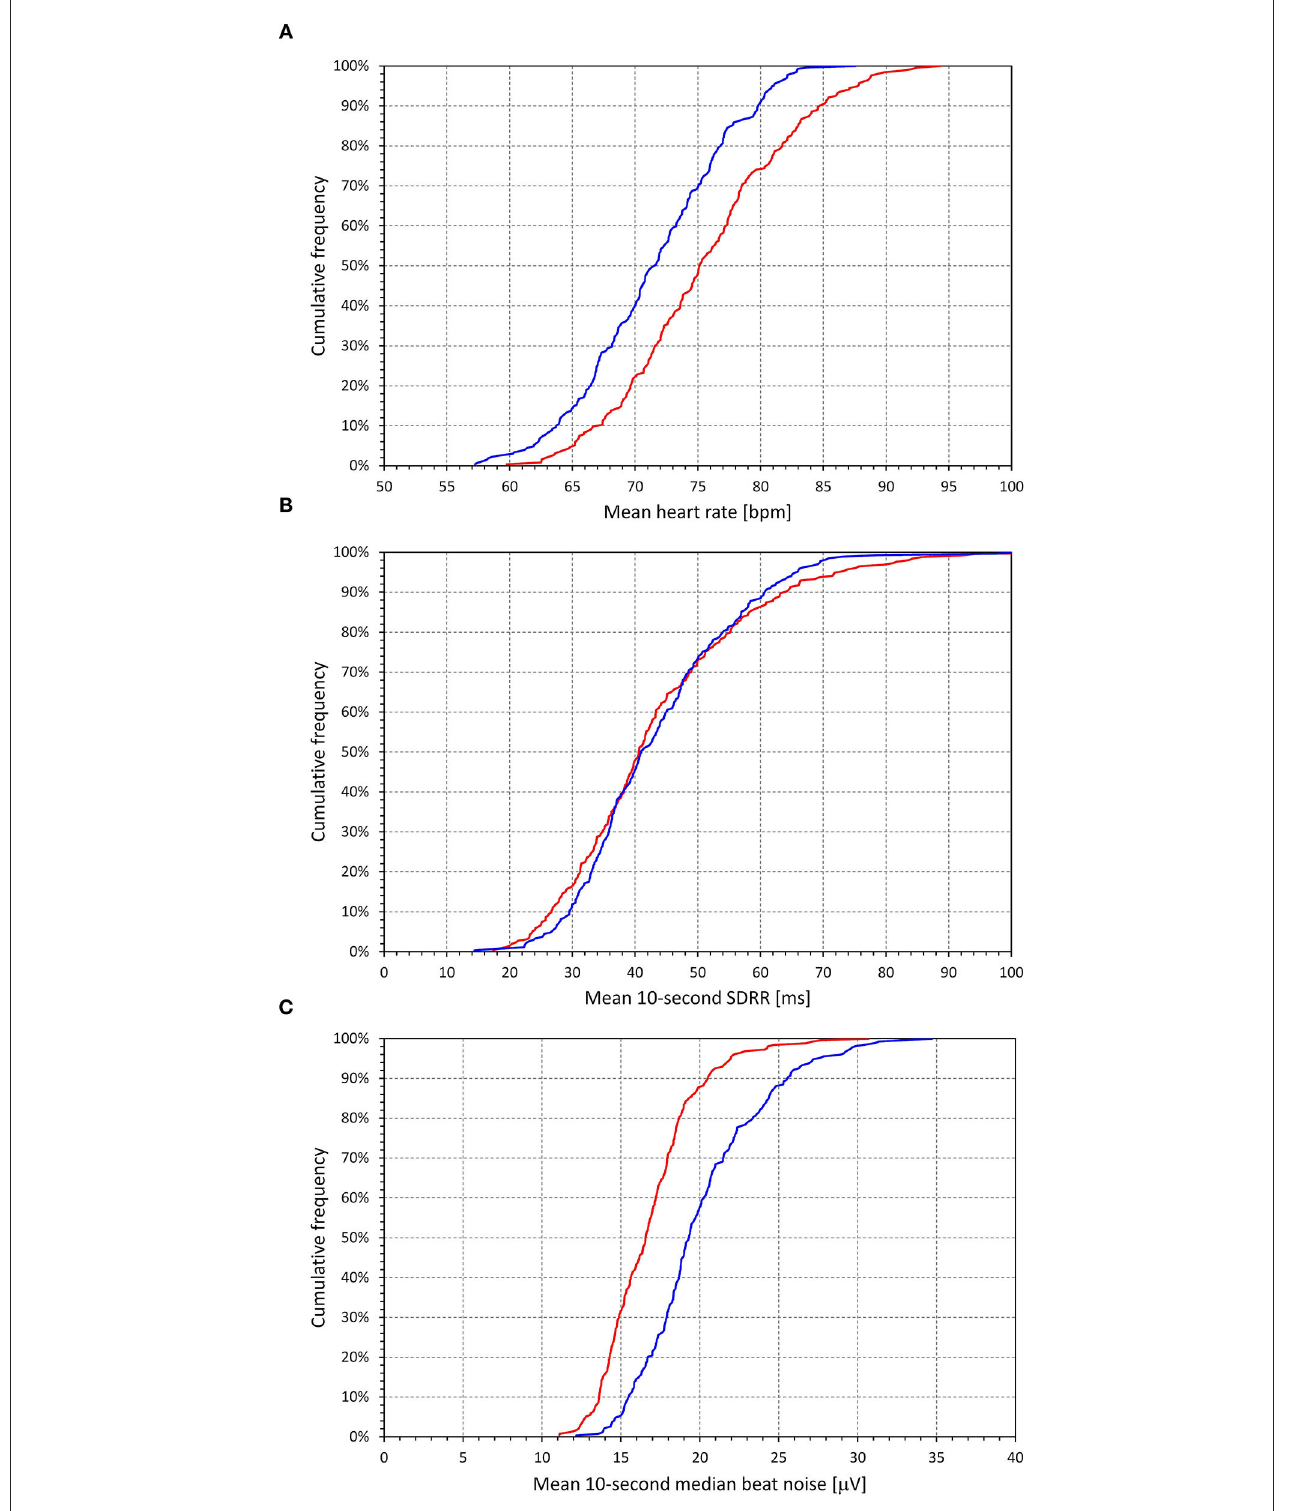
FIGURE 6 | Population distributions of principal ECG measurements (intra-subject means of measurements obtained in individual 10-s ECG segments accepted in the recordings of the given subject). The top (A) , middle (B) , and bottom (C) show the distributions of mean heart rates, mean values of SDRR, and mean values of 10-s median beat noise, respectively. In each panel, the red and blue lines show the distributions among females and males, respectively.